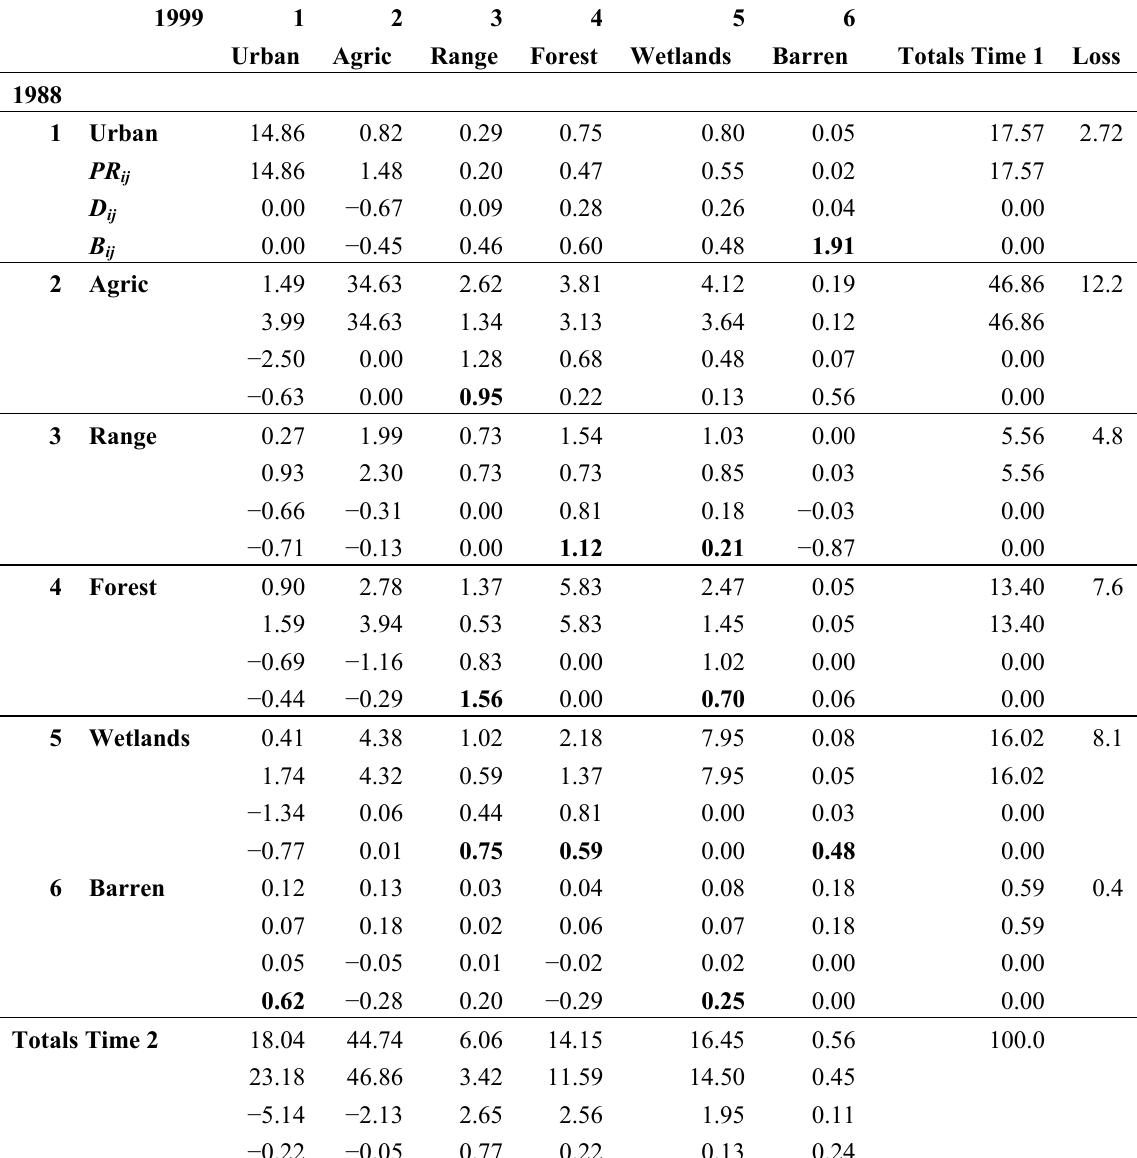
Table 5. Intercategory changes in the Caloosahatchee River Watershed in 1988–1999: Focus on